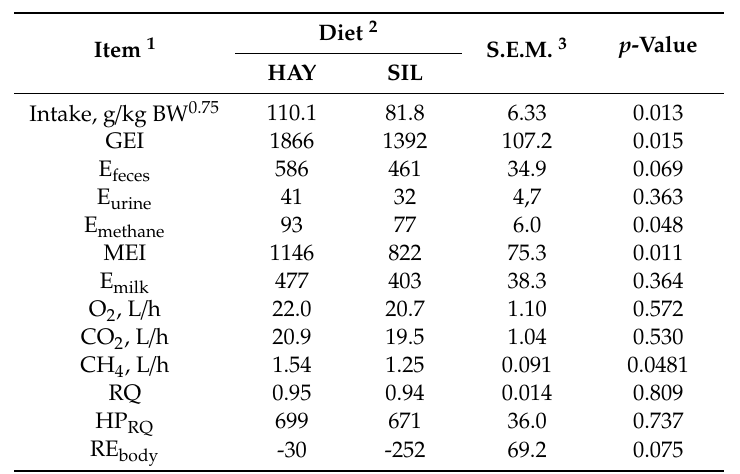
Table 6. RQ method; daily energy balance (kJ / kg BW 0.75 day) of 8 lactating Murciano-Granadina goats fed HAY (n = 4) or SIL (n = 4)